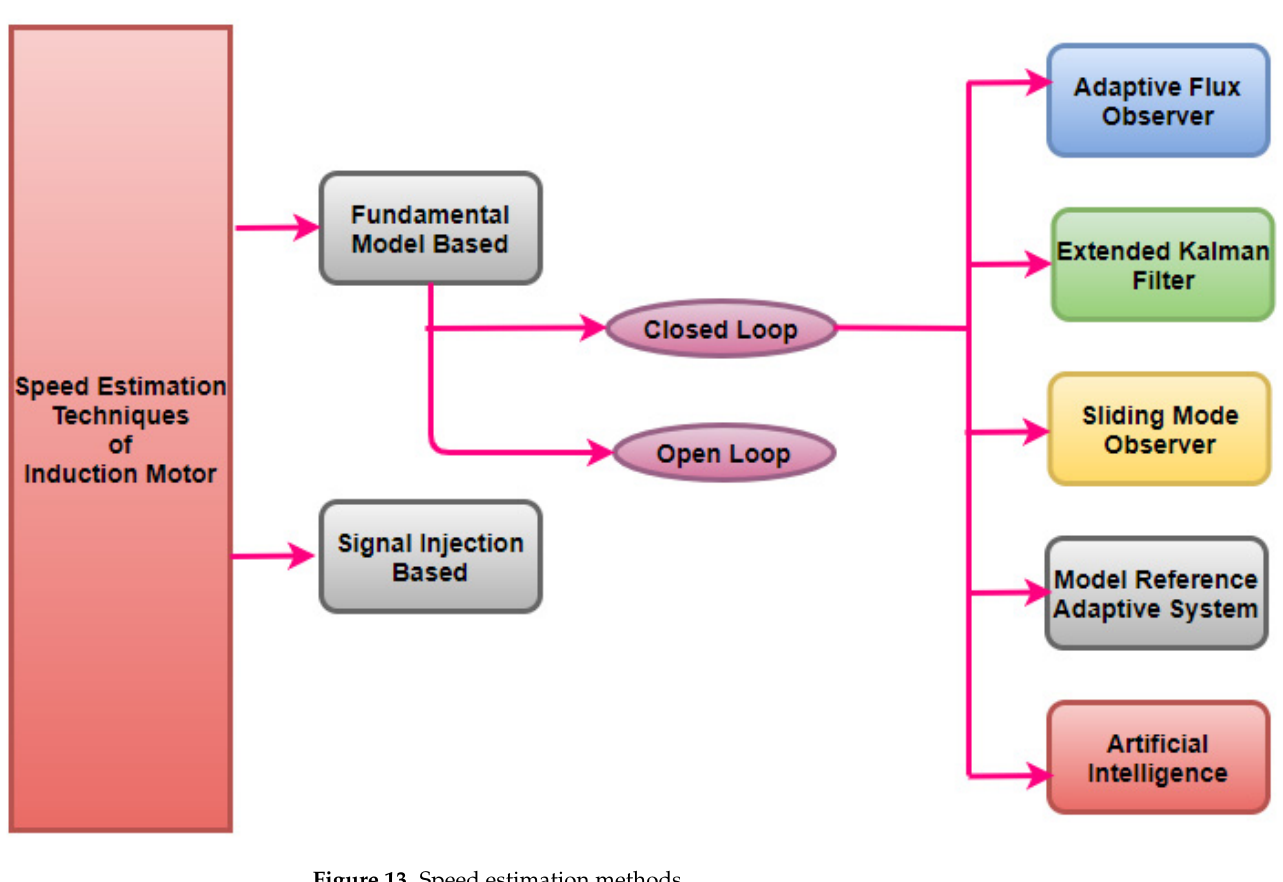
Figure 13. Speed estimation methods.